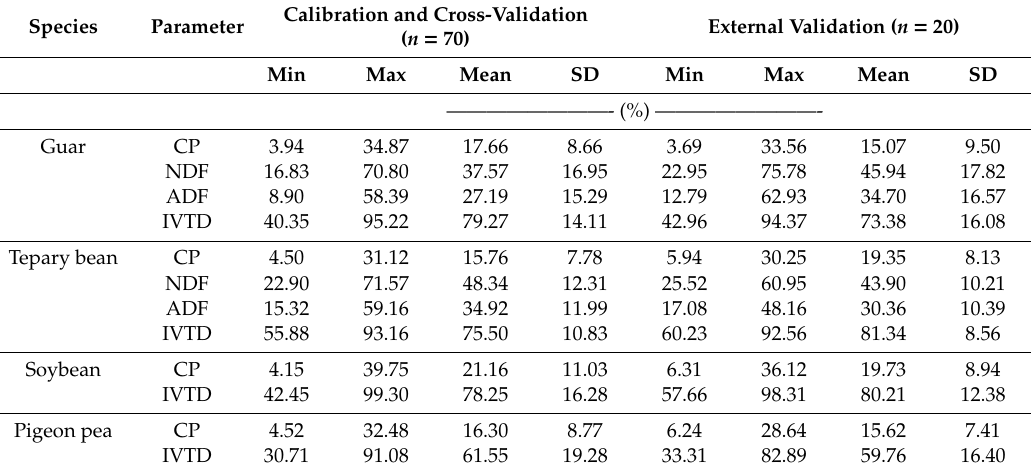
Table 1. Summary statistics of lab datasets used for calibration, cross-validation and external validation of crude protein (CP), neutral detergent fiber (NDF), acid detergent fiber (ADF), and in vitro true digestibility (IVTD) of four warm season legumes. Species